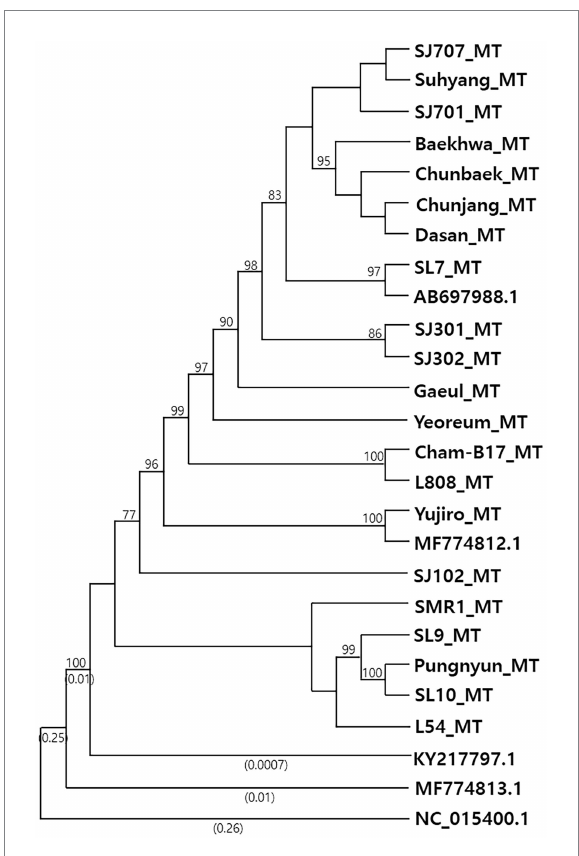
FIGURE 1 Phylogenetic analysis of Lentinula edodes mtDNAs. Phylogenetic tree was constructed using complete mtDNA sequences by the Neighbor-Joining method with 1,000 times of Bootstrap resampling. Bootstrap values greater than 70% are shown at branching points. Numbers enclosed in parentheses represent the branch lengths, and those shorter than 0.0005 are omitted. The mtDNA of Moniliophthora roreri (NC_015400.1) was used as an outgroup. Detailed information of the mtDNAs are summarized in Table